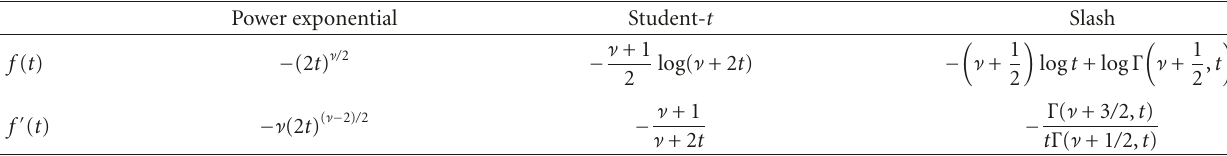
Table 2: The function f ( t ) and its first derivative for the three heavy-tailed distributions. For power exponential, the parameter ν must be set as 0 < ν ≤ 2 such that f ( t ) is convex. We note that f ( t ) and f (cid:3) ( t ) can be directly calculated from the distribution function. The knowledge of the exact form of p ( u | ν ) is not